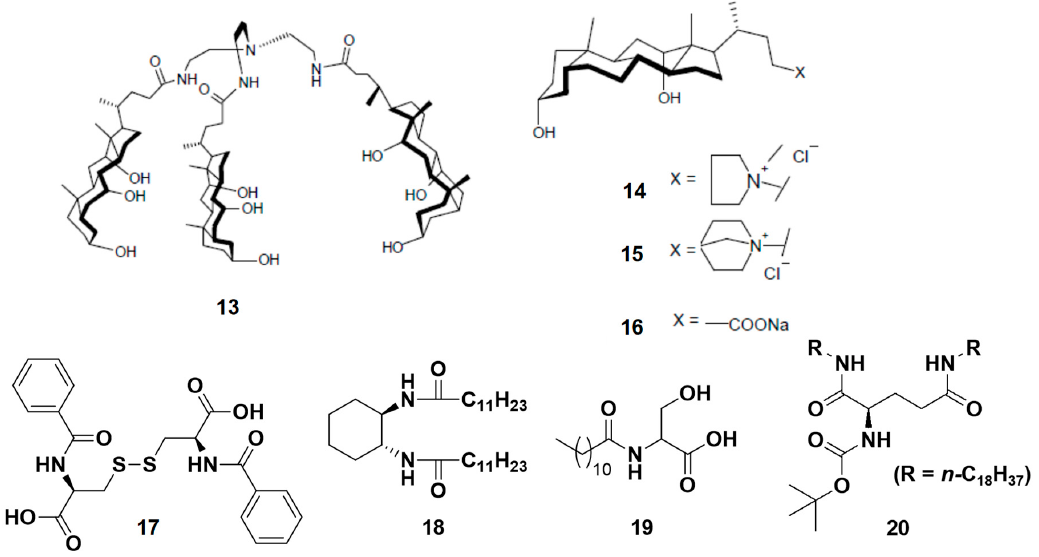
Chart 2. Various compounds used for the supramolecular gel ‐ based photochemical process.